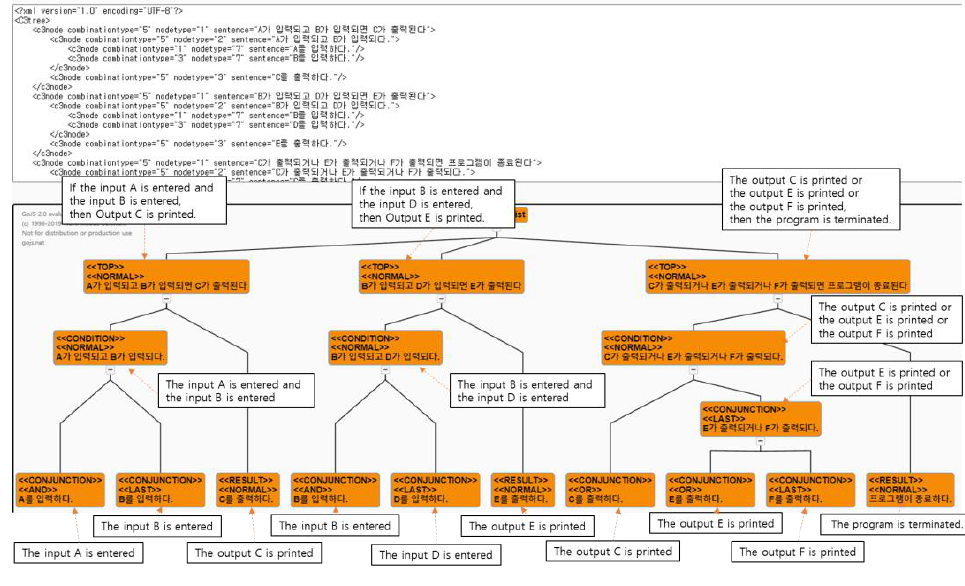
Figure 14. The automatic C3Tree model generation.